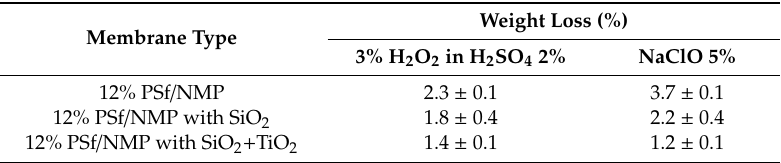
Table 2. Chemical resistance of polysulfone composite membranes.